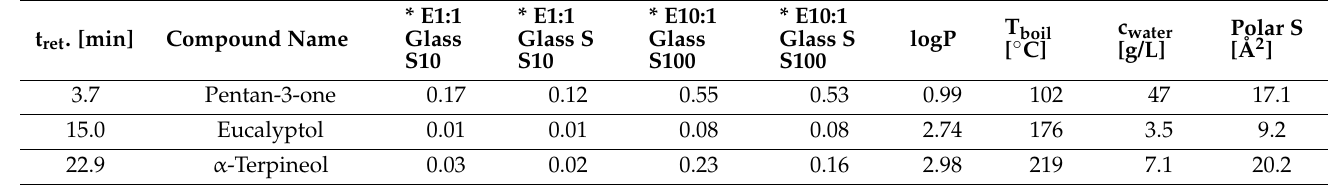
Table 3. Comparison of ratios of peak areas after the second and the first extraction and some physical properties (GC–MS retention time, partition coefficient, boiling point, and topological polar surface) of three compounds found in H. italicum hydrosol. Physical properties were obtained